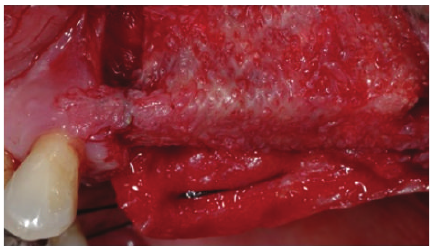
Figure 6: The time titanium mesh removal showed a good healing and the bone volume